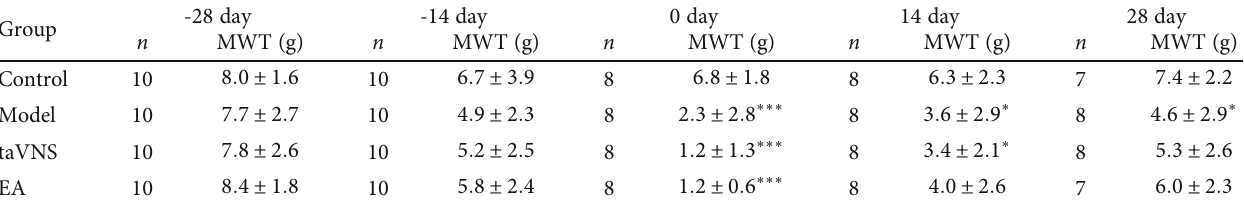
Table 3: Comparison of the mechanical withdrawal threshold in each group at di ff erent time points ( (cid:1) x ± s ). -28 day Group